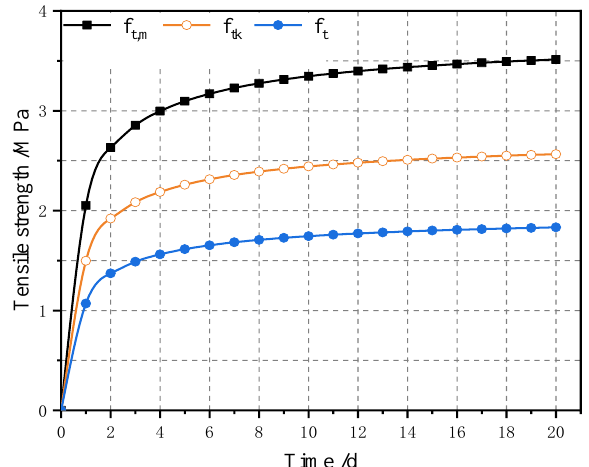
Figure 4. Tensile strength of C50 concrete.